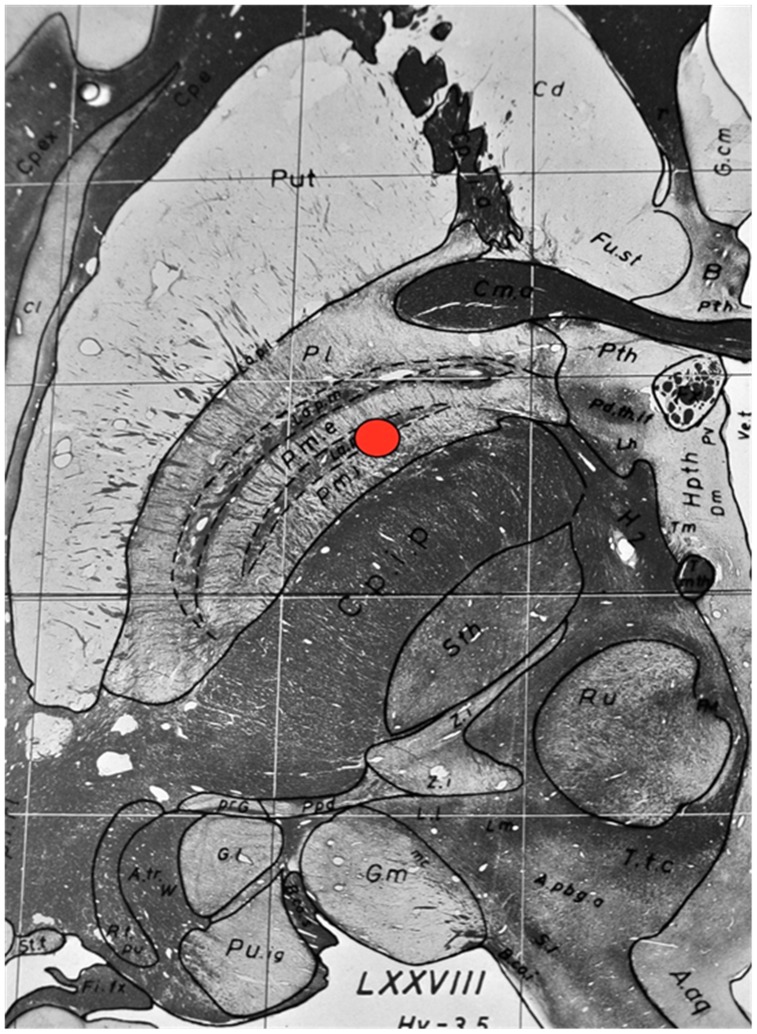
An image from the “Atlas for Stereotaxy of the Human Brain”: Schaltenbrand and Wahren, Plate 54 [25] showing a the stimulation target as red marker overlying the anteromedial pallidum on an axial brain slice at 3.5 mm below the AC/PC line.